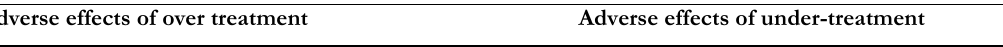
Table 2.6. Over and under-treatment with levothyroxine